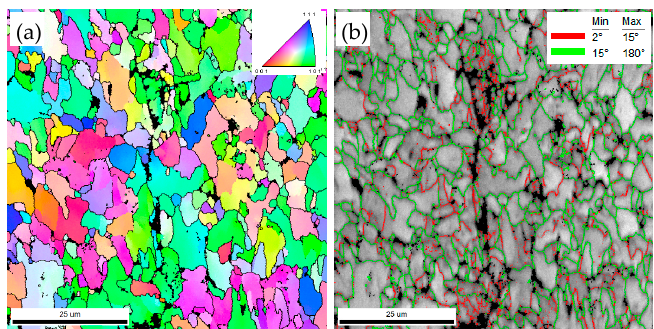
Figure 12. Crystallographic characteristics of the fatigue cracks at peak temperature of 1050 °C. ( a ) Orientation image maps; ( b ) Image quality maps with grain boundary misorientation distribution.